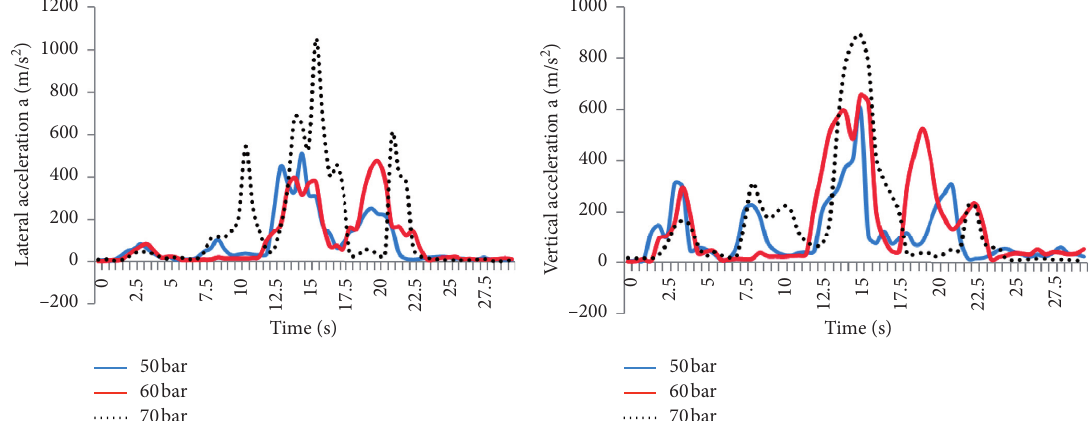
Figure 10: The envelope of acceleration of rail under different pressures.